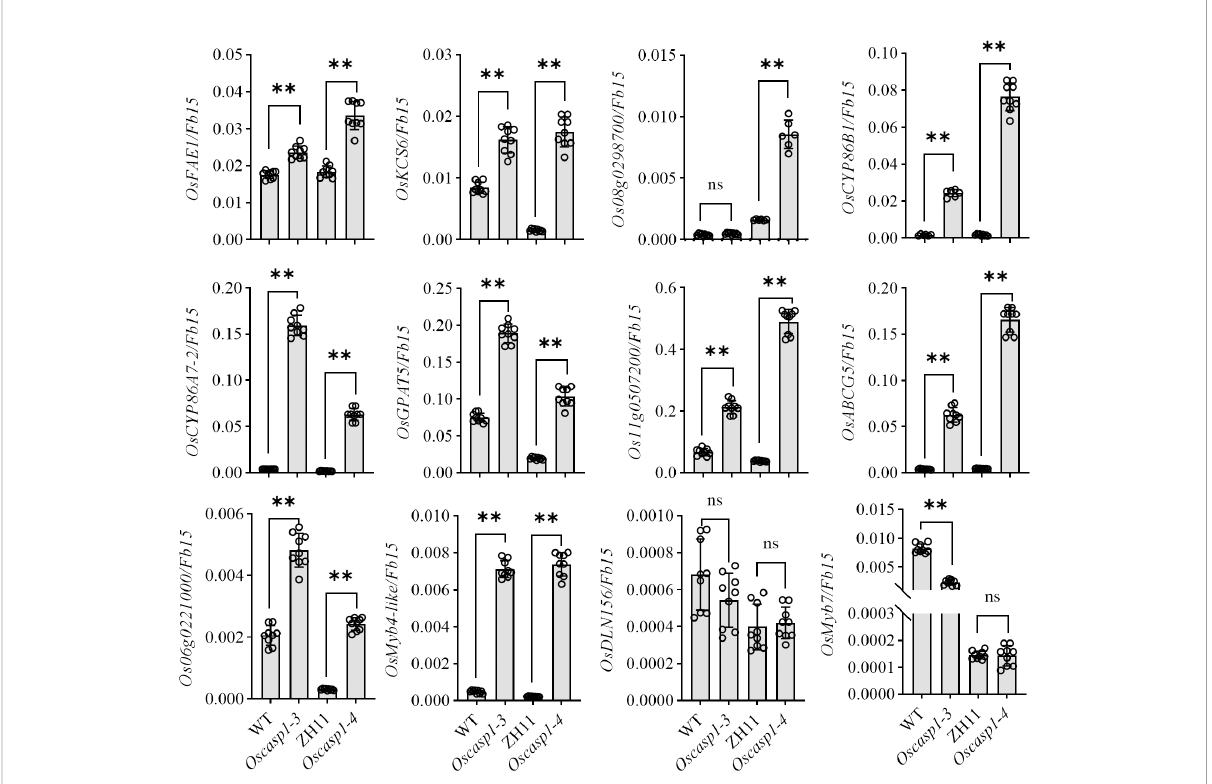
FIGURE 7 Expression levels of the genes involved in suberin synthesis. Student ’ s T-test was used for statistical analysis, and ** represents statistically signi fi cant difference (p value < 0.01); ns: no signi fi